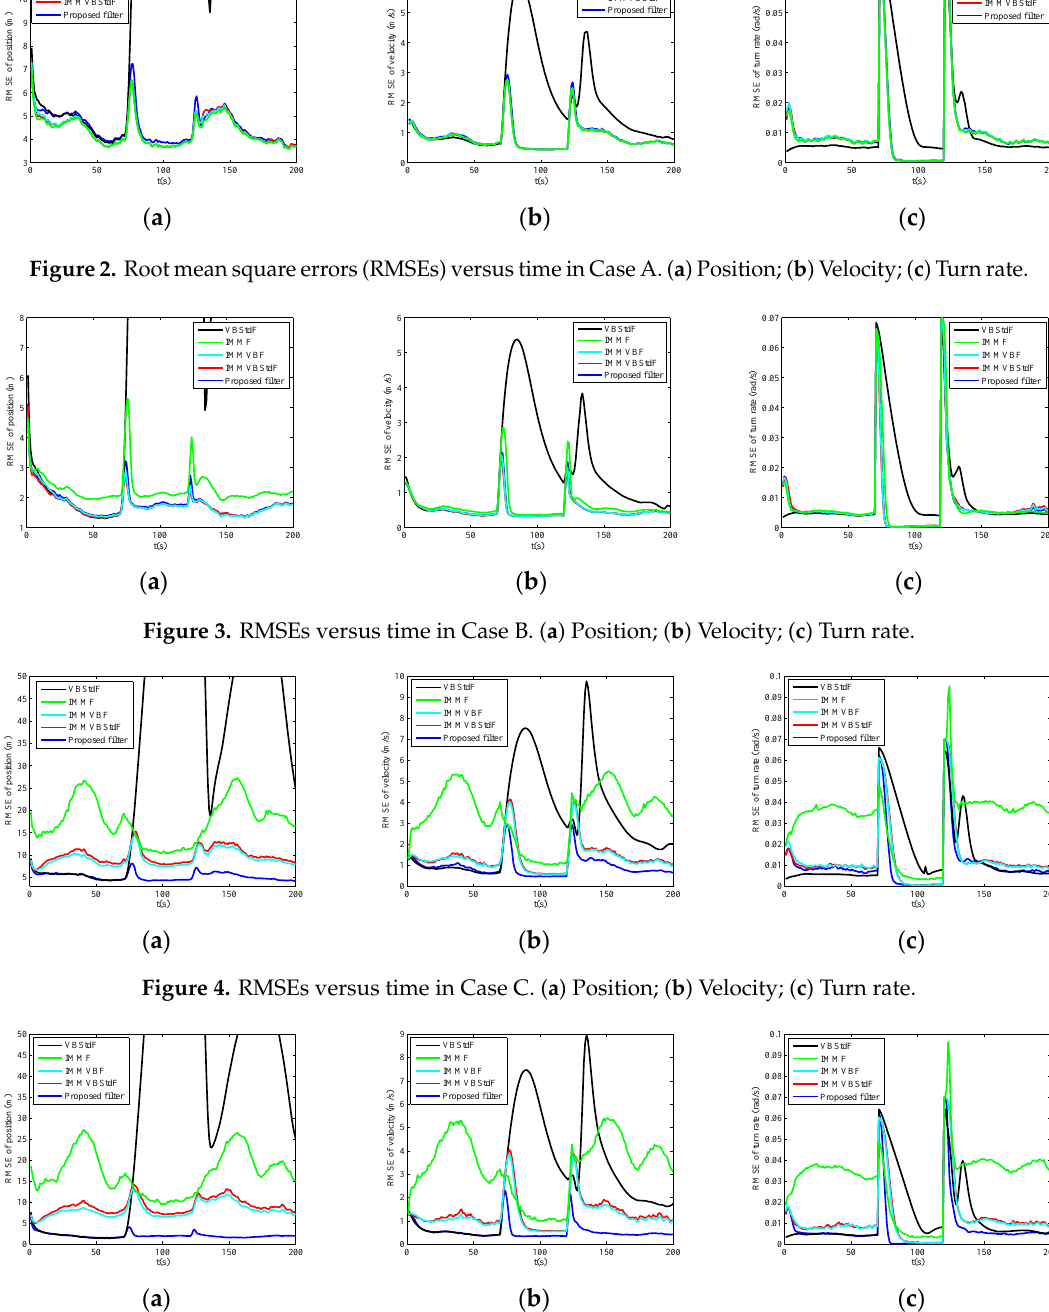
Figure 5. RMSEs versus time in Case D. ( a ) Position; ( b ) Velocity; ( c ) Turn rate. Table 1. Average root mean square errors of filters in four cases.